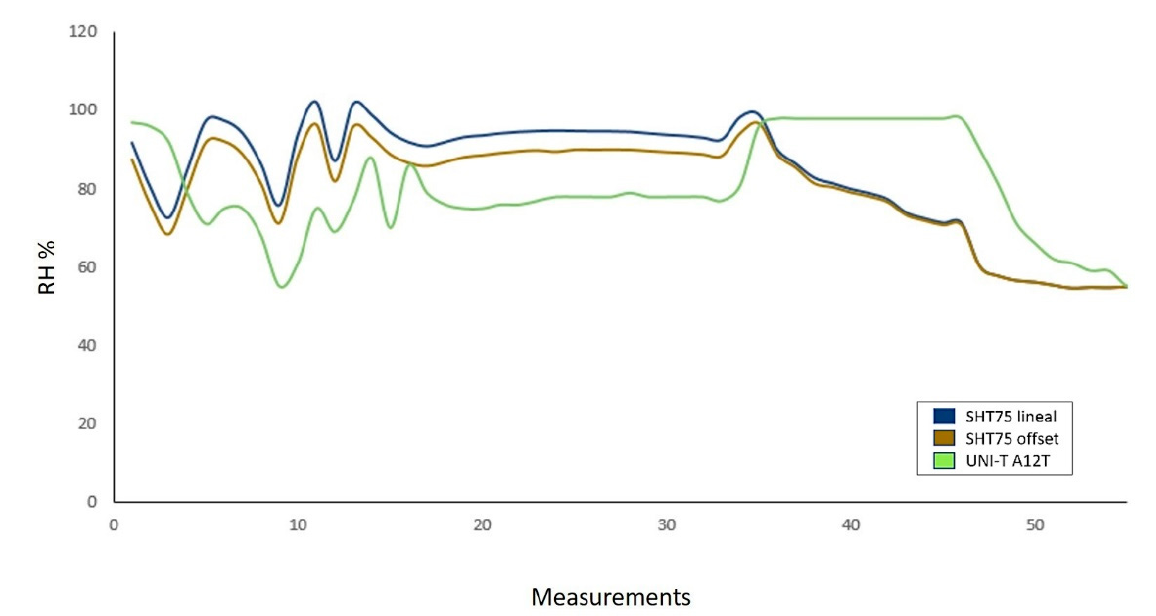
Figure 11. Comparison of measurements made by the UNI-T A12T sensor and the SHT75 sensor. The RH measured ranges were from 50 to 100%. In total, 55 measurements were made.